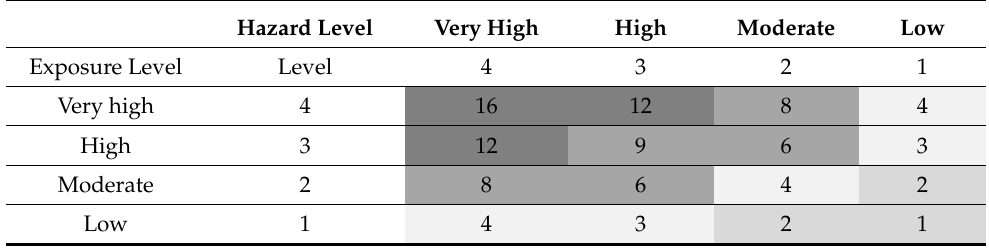
Table 3. Estimation of the risk level of chemical substances. Hazard Level Very High High Moderate Low Exposure Level Level 4 3